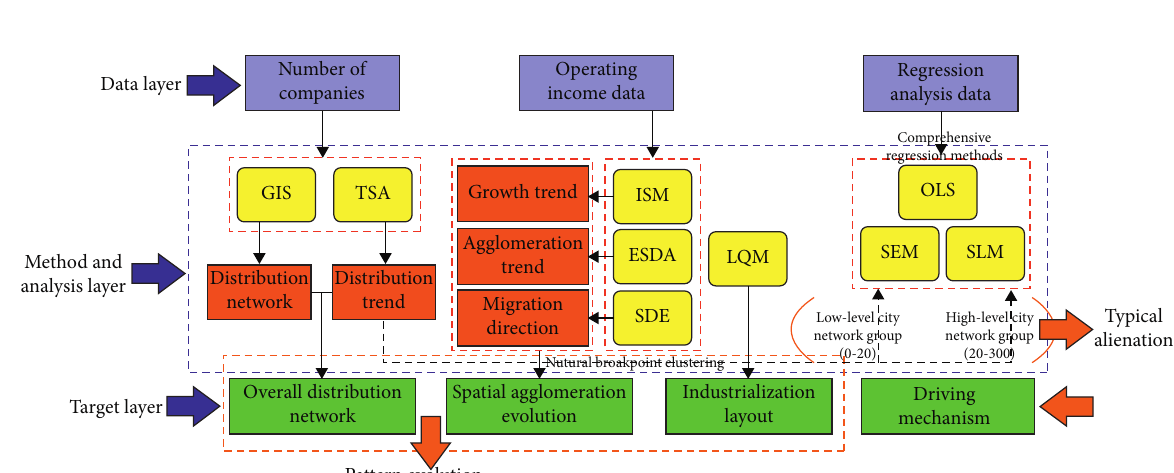
Figure 2: Research ideas framework.